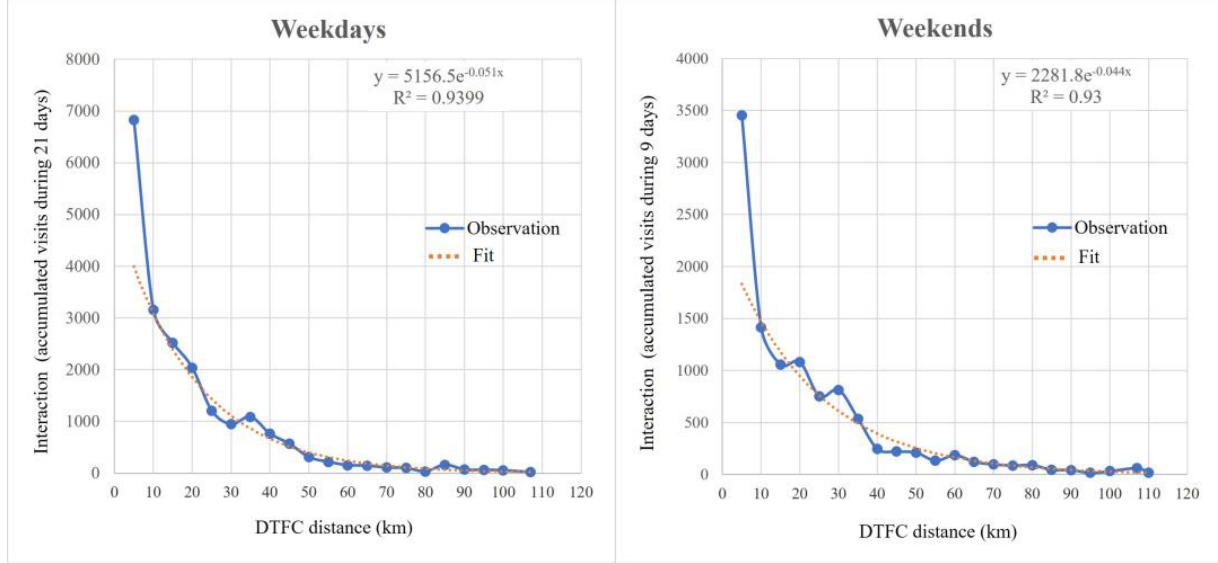
Figure 7. Influences by time factors: no significant influence on weekdays and weekends. Nevertheless, there are statistical differences between workdays and non-workdays. For weekdays, there are drop and peak at 30 km and 35 km point respectively; in contrast, the curve over the weekends show more fluctuates, with two peaks both at 20 km and 30 km point.